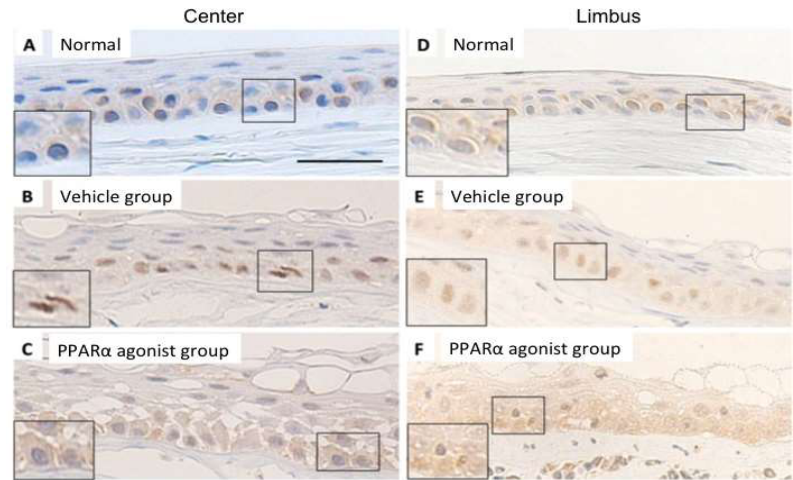
Figure 7. The localization of NF- κ B p65 in normal cornea and in alkali-burned cornea in the vehicle and PPAR α agonist groups at day 1. Immunohistochemical localization of NF- κ B in normal cornea of center ( A ) and limbus ( D ) showed the weaker diffuse labeling in the cytoplasm in the epithelial basement cells. In the alkali-burned cornea of center ( B ) and limbus ( E ) in the Vehicle group, NF- κ B-positive nuclei were prominent in the epithelial basement cells, indicating nuclear translocation of NF- κ B developed in the alkali-burned cornea. However, in the alkali-burned cornea of center ( C ) and limbus ( F ) in the PPAR α agonist groups, the location of NF- κ B was noted in the cytoplasm of the epithelial basement cells, suggesting the prevention of nuclear translocation of NF- κ B by PPAR α agonist. Scale bar: 20 µ m.